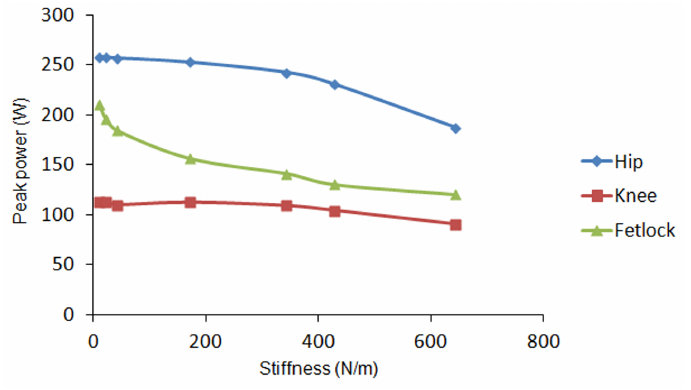
Figure 9. Effect of spring stiffness on the power required at the hip, knee and fetlock joints.